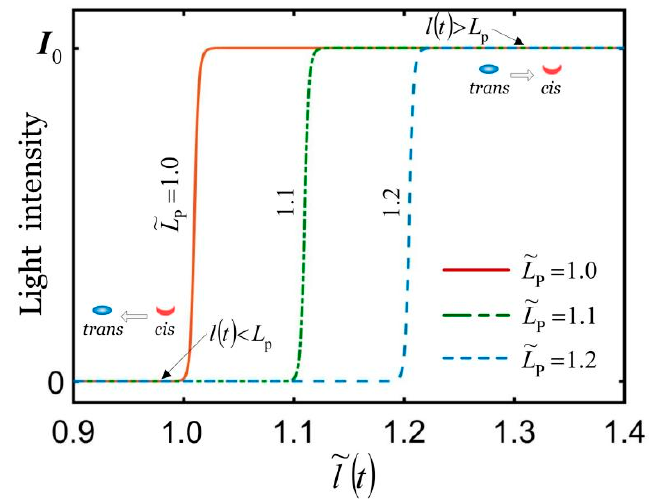
Figure 3. The shading effect of shading coating. For l ( t ) > L p , the LCE fiber is in an illuminated state. For l ( t ) ≤ L p , the LCE fiber is in a non-illuminated state. The self-excited oscillation of the mass block can be triggered under uniform and constant illumination due to the self-shading effect of the coating.